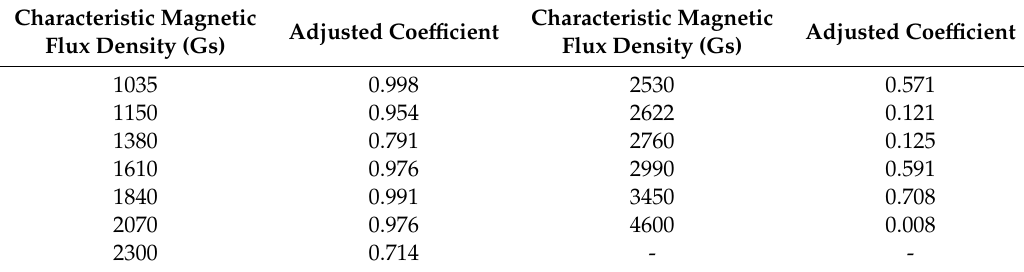
Table 3. Adjusted coe ffi cient of the deposition depth model.